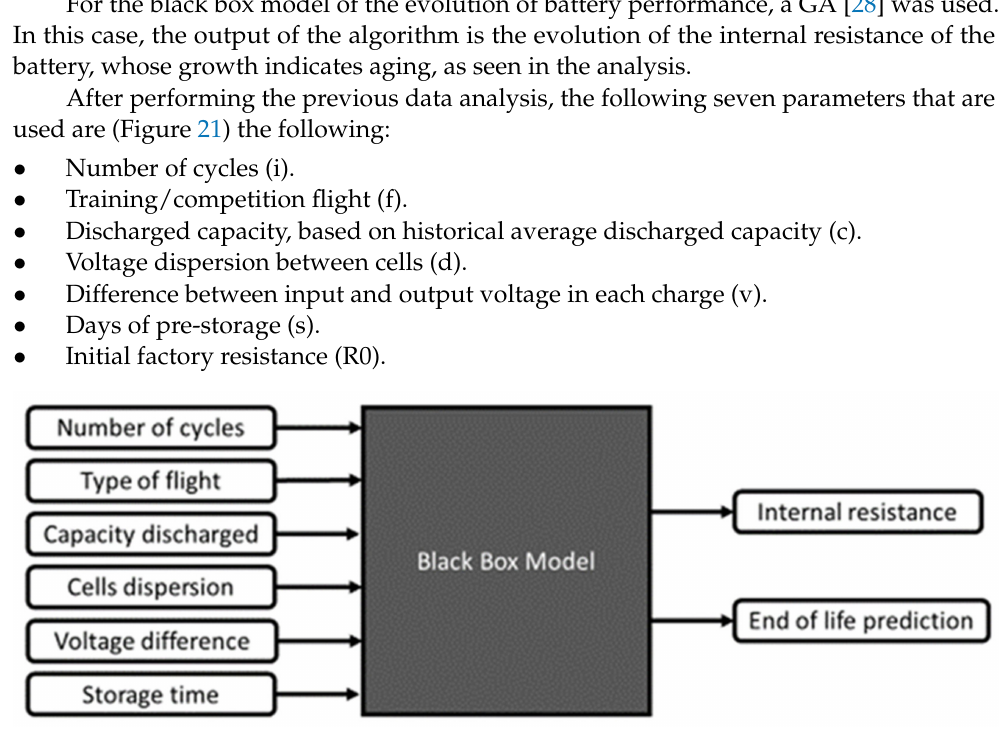
Figure 21. Black box model flow